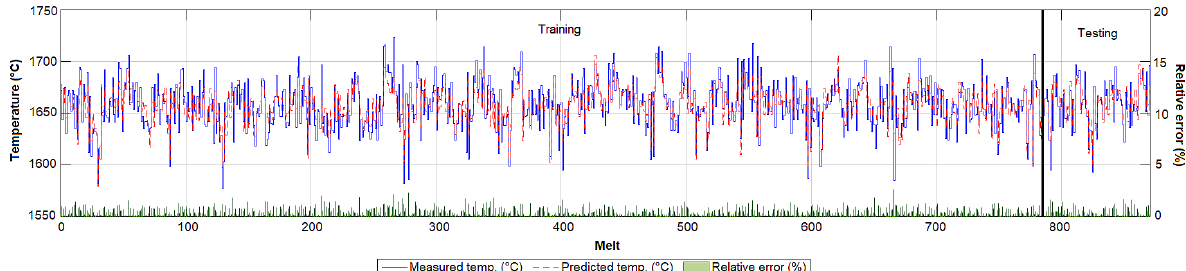
Figure 8. Prediction of endpoint melt temperature by piecewise-linear MARS model.